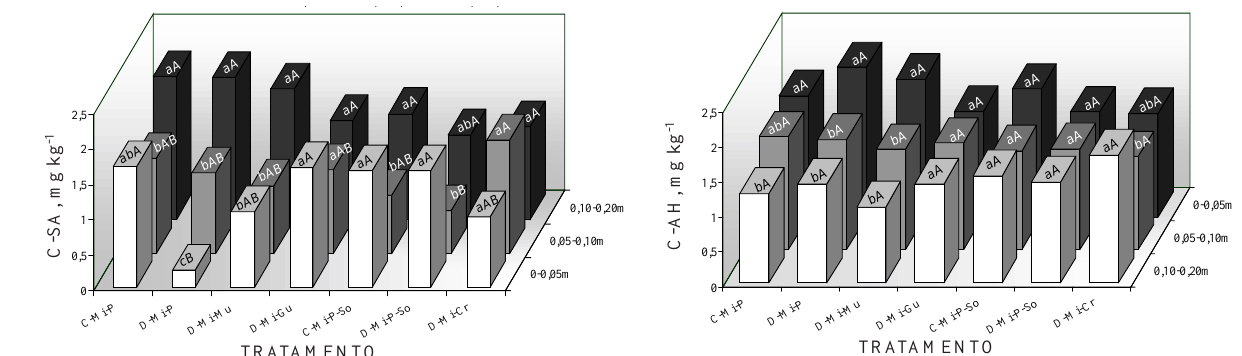
Figura 3. Teores de carbono na fração ácido fúlvico em um Latossolo Roxo cultivado com milho sob diferentes sistemas de produção por seis anos. C = sistema de semeadura convencional; D = sistema plantio direto; Mi = milho semeado no verão; So = soja semeada no verão; P = pousio no inverno; Mu = semeadura de mucuna preta no inverno; Gu = semeadura de feijão guandu no inverno; Cr = semeadura de crotalária no inverno. Médias seguidas de mesma letra não diferem entre si pelo Teste de Tukey, a 5 %. Letras minúsculas comparam médias dispostas na vertical. Letras maiúsculas comparam médias dispostas na horizontal.